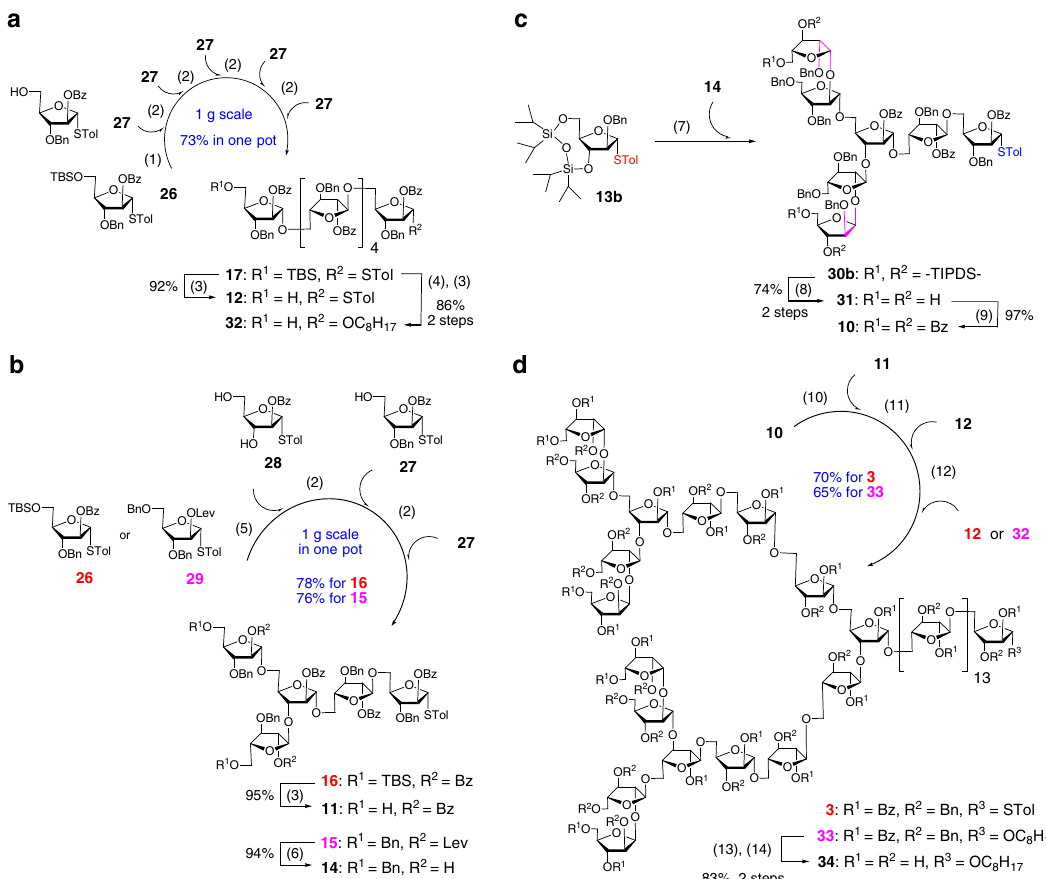
Figure 3 | Synthesis of Ara f 31 donor 3. ( a ) Synthesis of oligosaccharides 12 and 32 ; ( b ) Synthesis of diols 11 and 14 ; ( c ) Synthesis of heptasaccharide 10 ; ( d ) Synthesis of Ara f 31 donor 3 and 31-mer arabinan 34 . Reagents and conditions: (1) TTBP, 4Å MS, CH 2 Cl 2 , p -TolSCl, AgOTf, then 27 , (cid:2) 78 (cid:2) C to room temperature; (2) p -TolSCl, AgOTf, then 27 , (cid:2) 78 (cid:2) C to room temperature; (3) TBAF, AcOH, THF; (4) p -TolSCl, AgOTf, TTBP, 1-octanol, 4Å MS, CH 2 Cl 2 , (cid:2) 78 (cid:2) C; (5) TTBP, 4Å MS, CH 2 Cl 2 , p -TolSCl, AgOTf, then 28 , (cid:2) 78 (cid:2) C to room temperature; (6) H 2 NNH 2 -AcOH, THF/CH 3 OH (10:1); (7) p -TolSCl, AgOTf, then 14 , (cid:2) 78 (cid:2) C; (8) TBAF, THF; (9) Bz 2 O, DMAP, pyridine, CH 2 Cl 2 , reflux; (10) TTBP, 4Å MS, CH 2 Cl 2 , p -TolSCl, AgOTf, then 11 , (cid:2) 78 (cid:2) C to room temperature; (11) p -TolSCl, AgOTf, then 12 , (cid:2) 78 (cid:2) C to room temperature; (12) p -TolSCl, AgOTf, then 12 or 32 , (cid:2) 78 (cid:2) C to room temperature; (13) NaOCH 3 , CH 3 OH/CH 2 Cl 2 (2:1); (14) Pd/C, H 2 , EtOAc/THF/1-PrOH/H 2 O (2:1:1:1). TBAF, tetra- n -butylammonium